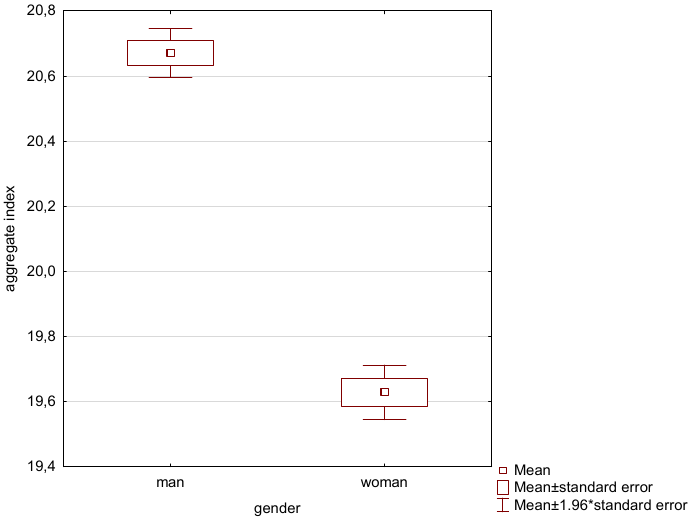
Figure 8. The level of the aggregate indicator in 2018 by sex of the person representing the household of people aged 60 and older. Source: own elaboration based on data from [136].